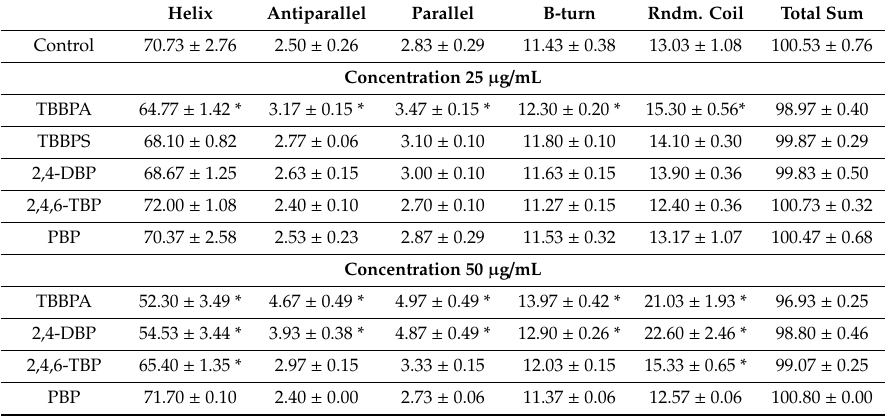
Figure 3. Circular dichroism (CD) spectra of HSA (1 µ M) treated with TBBPA (1–50 µ g / mL), TBBPS (1–25 µ g / mL) and 2,4-DBP, 2,4,6-TBP, PBP (1–50 µ g / mL). Table 2. Composition of the secondary structure of HSA exposed to BFRs studied.